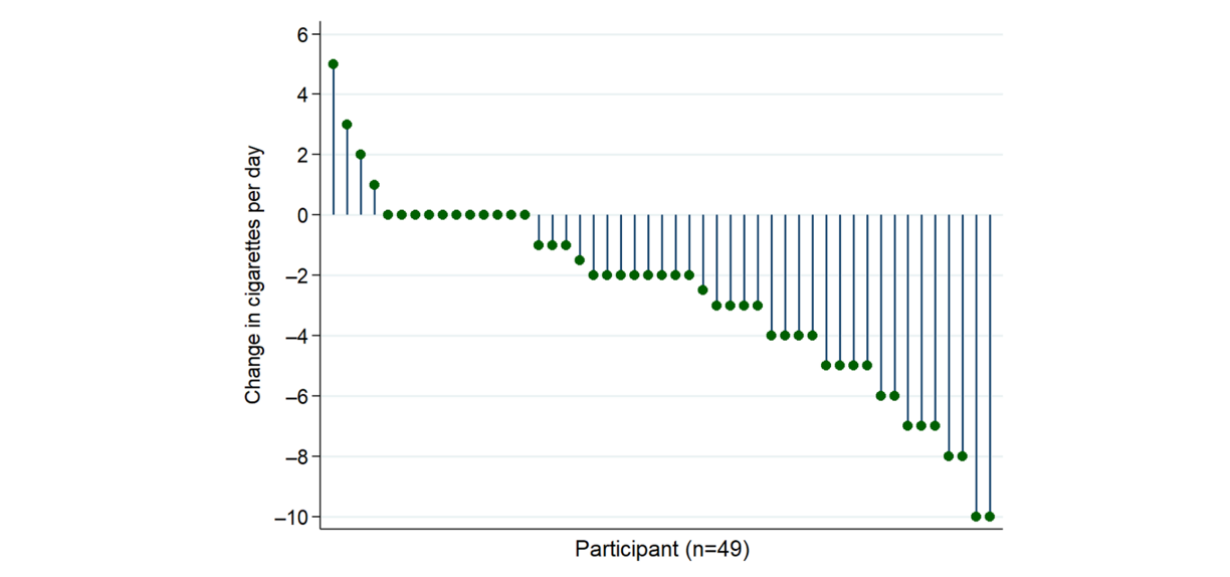
Figure 5. Change in cigarettes per day between baseline and